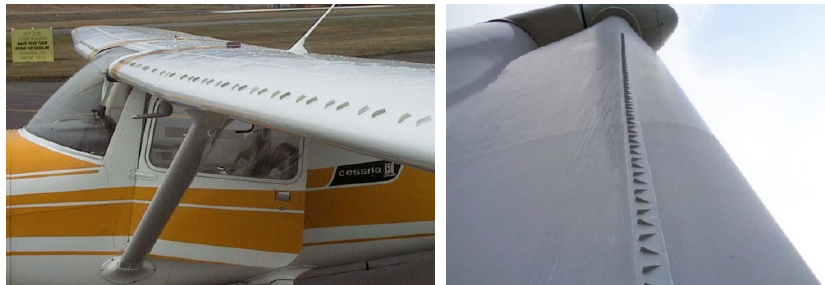
Figure 1. Applications of passive vortex generators (VGs) on the aircraft wings and wind turbine blades [15,16].